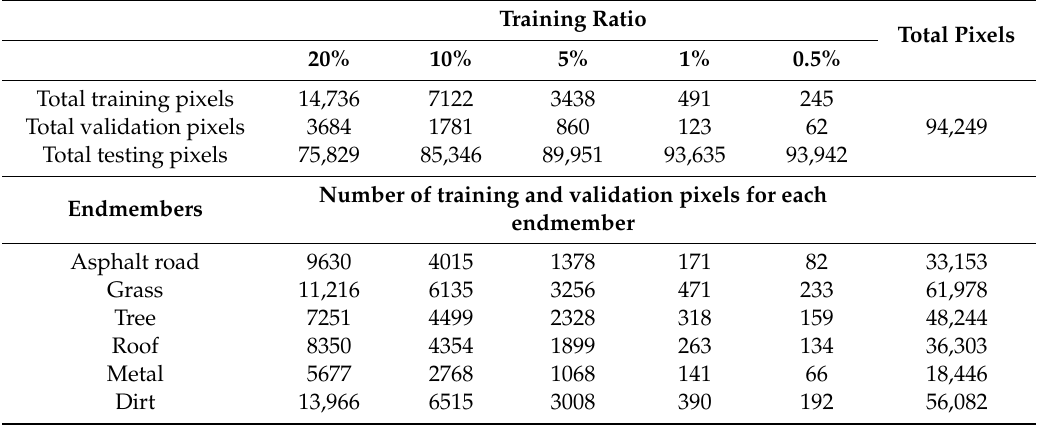
Table 1. Number of the training, cross-validation and testing pixels in the Urban